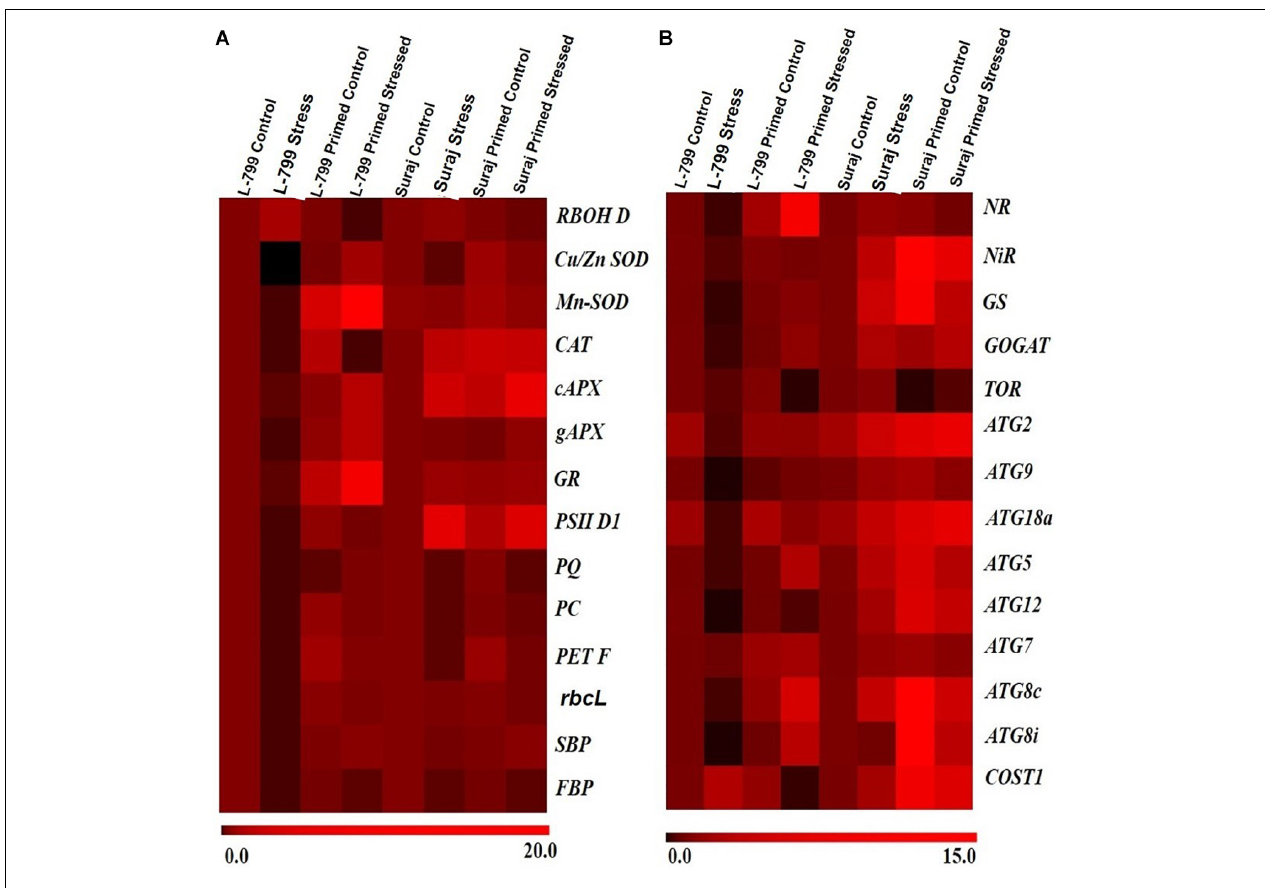
FIGURE 10 | A differential expression pattern of candidate stress-responsive genes in two drought-distinguished cotton varieties, L-799 and Suraj, under drought condition with and without melatonin priming. (A) Genes involved in antioxidant systems and photosynthesis, (B) genes involved in nitrogen metabolism and autophagy. Values are means of 3 independent